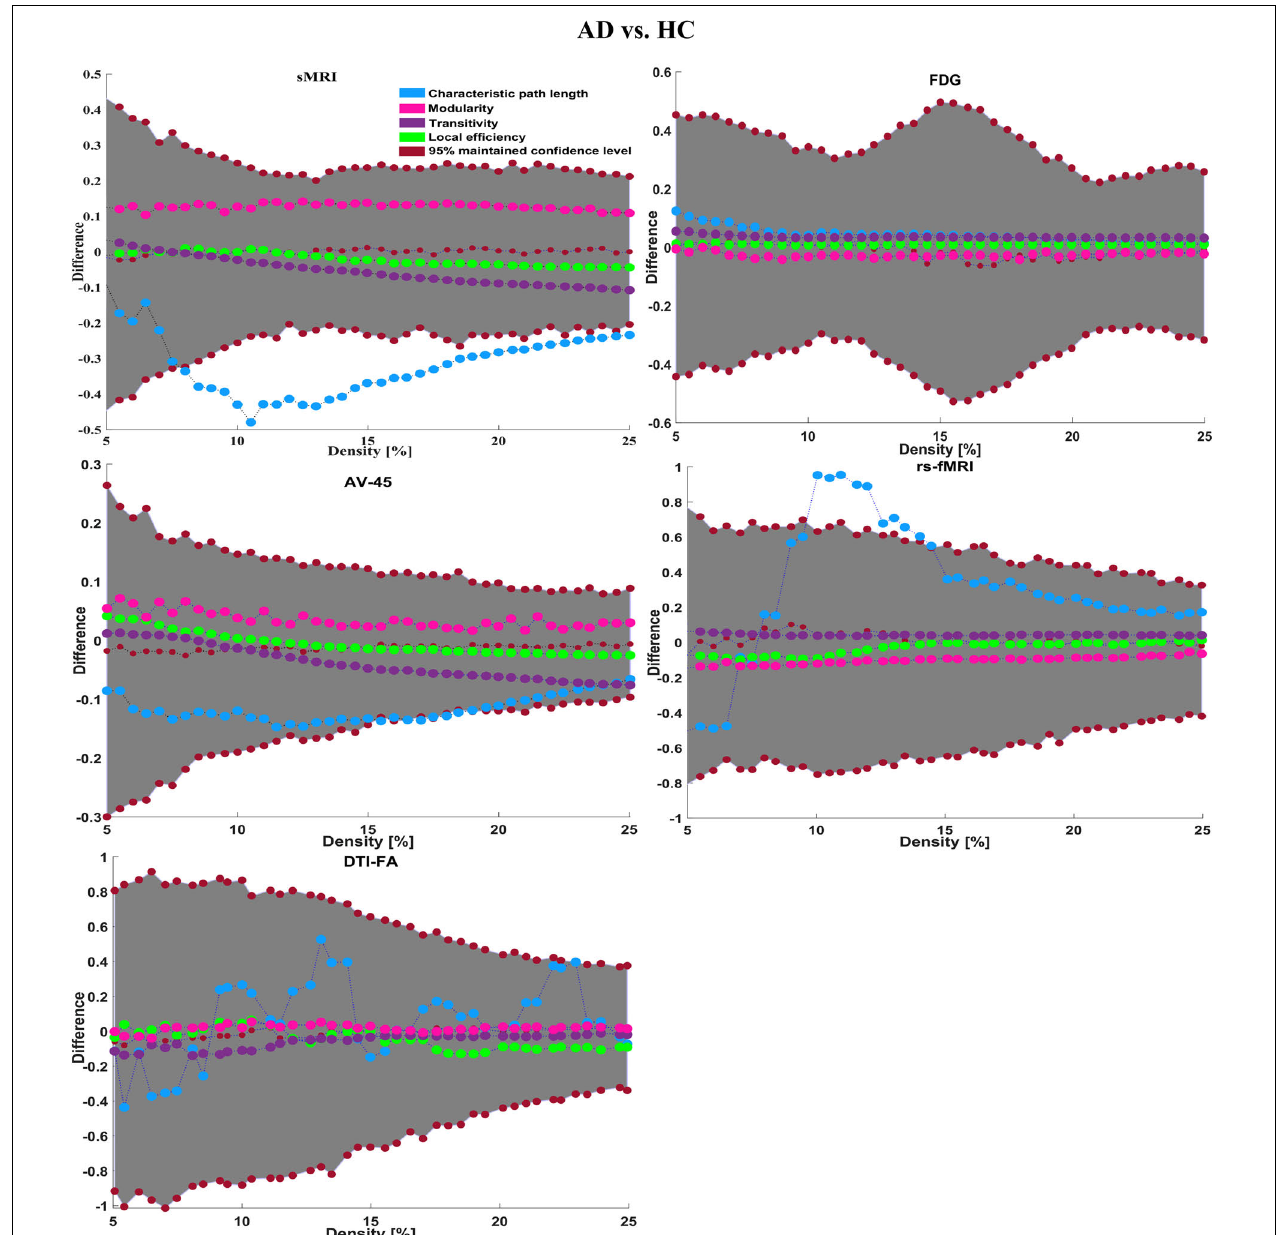
FIGURE 12 | Differences between the AD vs. HC group in global structural topology. The blue sphere represents characteristic path length, green sphere represents local efficiency, pink sphere represents modularity, purple sphere represents transitivity, and the dark red sphere represents 95% confidence intervals for these